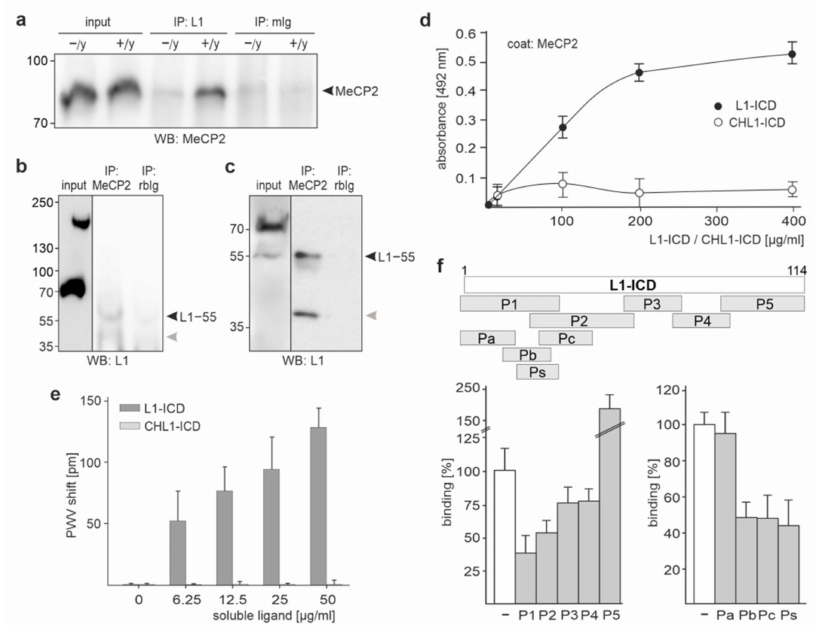
Figure 1. L1-ICD binds directly to MeCP2. Nuclear fractions were isolated from brains of wild-type (+/y) and L1-deficient ( − /y) mice using protocol A ( a , b ) or B ( c ). These nuclear brain extracts were subjected to immunoprecipitation (IP) with L1 antibody C-2 ( a ), MeCP2 antibody ( b , c ), or non-immune control antibodies (mIg; rbIg) ( a – c ). Immunoprecipitates were then subjected to West- ern blot analysis with antibodies against MeCP2 ( a ) or L1 ( b , c ). Bands for MeCP2 ( a ) and L1 − 55 ( b , c ) are indicated by black arrowheads. Grey arrowheads indicate a band of ~40 kDa, which is recognized by the L1 antibody C-2. ( d ) Recombinant MeCP2 was substrate-coated and incubated with increasing concentrations of L1-ICD or CHL1-ICD. Binding was determined by ELISA using mouse L1 antibody C-2, goat CHL1 antibody, and horseradish peroxidase-conjugated secondary antibodies. Mean values ± SEM from three independent experiments carried out in triplicates are shown. ( e ) Recombinant MeCP2 was used as substrate-coat in a label-free binding assay and incu- bated with increasing concentrations of L1-ICD or CHL1-ICD. Binding was determined by measuring the peak wavelength (PWV) shift. Mean values + SD from three independent experiments carried out in triplicates are shown. ( f ) Recombinant MeCP2 was substrate-coated and incubated with L1-ICD in the absence ( − ) or presence of a 5-fold excess of L1 peptides P1, P2, P3, P4, or P5, which cover the entire L1-ICD sequence, or presence of a 5-fold excess of L1 peptides Pa, Pb, Pc, or Ps, which cover the N-terminal, membrane-proximal 43 amino acids of L1-ICD. The scheme indicates the positions of the peptides (grey bars) in L1-ICD (white bar) comprising 114 amino acids, which correspond to the amino acids 1147–1260 of mouse L1 (L1CAM_MOUSE, P11627). Binding was determined by ELISA using mouse L1 antibody C-2 and horseradish peroxidase-conjugated secondary antibodies. Mean values + SD from three independent experiments carried out in triplicates are shown for L1-ICD alone (white bars) and L1-ICD in the presence of peptide (grey